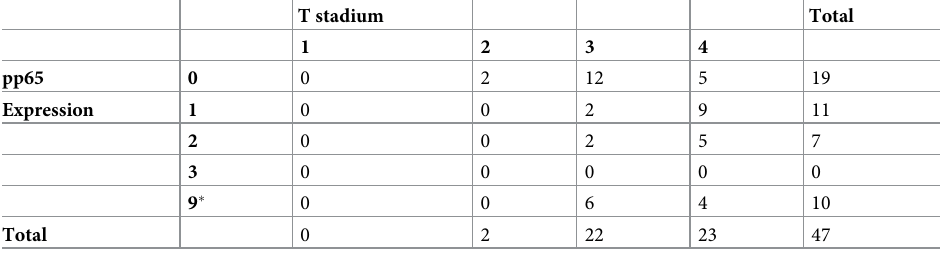
Table 2. CMV pp65 immunoreactivity vs T-stadium in